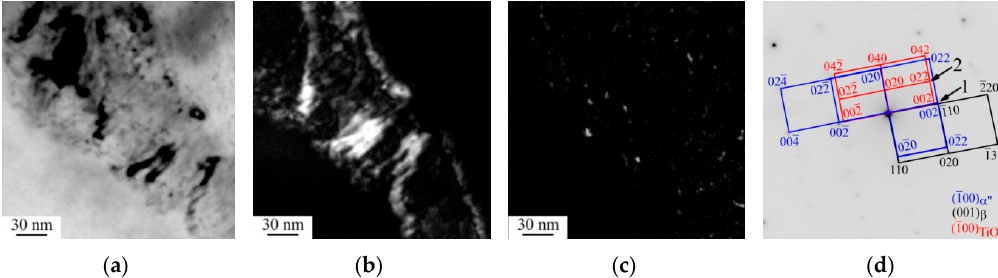
Figure 7. TEM bright- ( a ) and dark-field images ( b,c ) and associated selected area electron diffraction (SAED) pattern ( d ) of the microstructures within the outermost surface layer of the EBF 3 -fabricated Ti–6Al–4V sample. b —the dark-field TEM image obtained with the 002 α ”-Ti , 110 β -Ti , and 002 TiO reflections (marked by an arrow 1 in ( d )), c —dark-field TEM image obtained with the 022 TiO reflection (marked by an arrow 2 in ( d )).